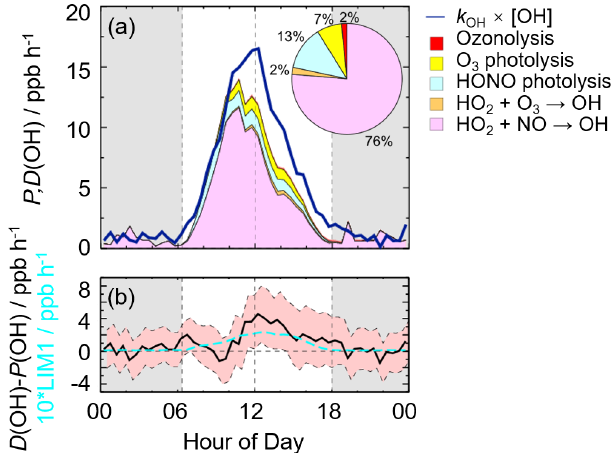
Figure 4. (a) The diurnal profiles of OH production and destruc- tion rates and the proportions of different known sources in the cal- culated production rate during the daytime. The blue line denotes the OH destruction rate, and the colored areas denote the calculated OH production rates from the known sources. (b) The missing OH source, which was the discrepancy between the OH destruction and production rates, and the OH production rate, which was 10 times the production rate derived from the LIM1 mechanism. The red shaded areas denote the combined uncertainty from the experimen- tal errors of the measured quantities (Table S1) and the reaction rate coefficients. The grey areas denote nighttime. Figure 5. NO dependence on OH and HO